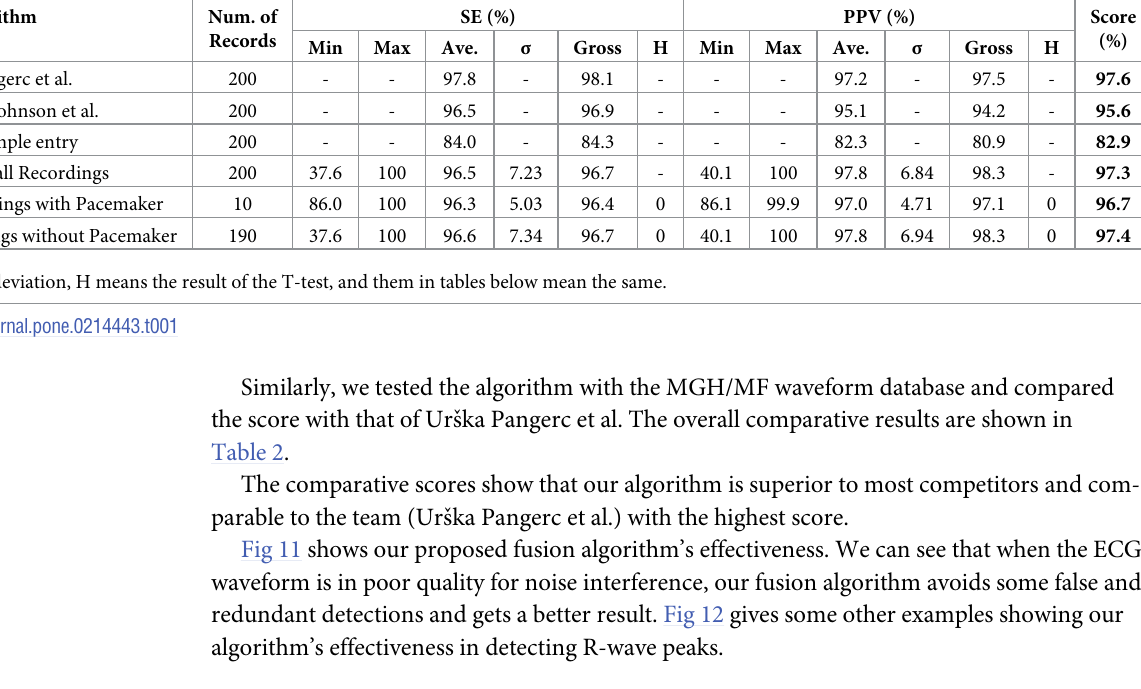
Table 1. Results of different techniques on the updated challenge training database. Algorithm